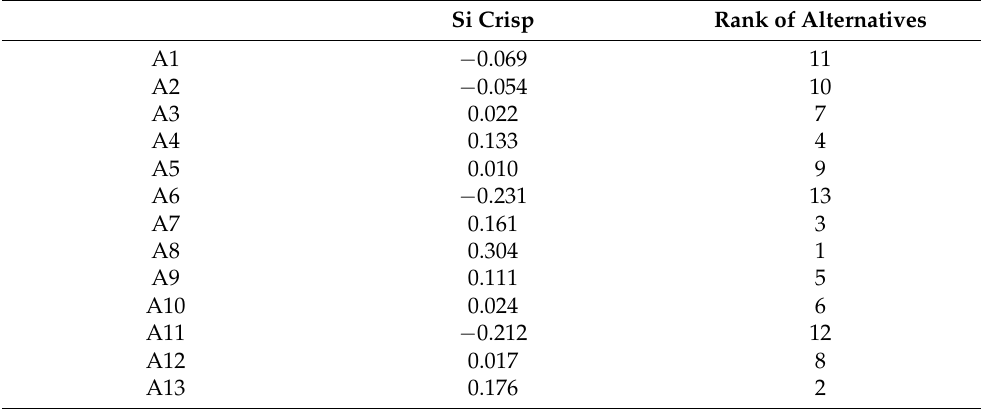
Table 12. Crisp values of criteria functions of alterntives and their rank.